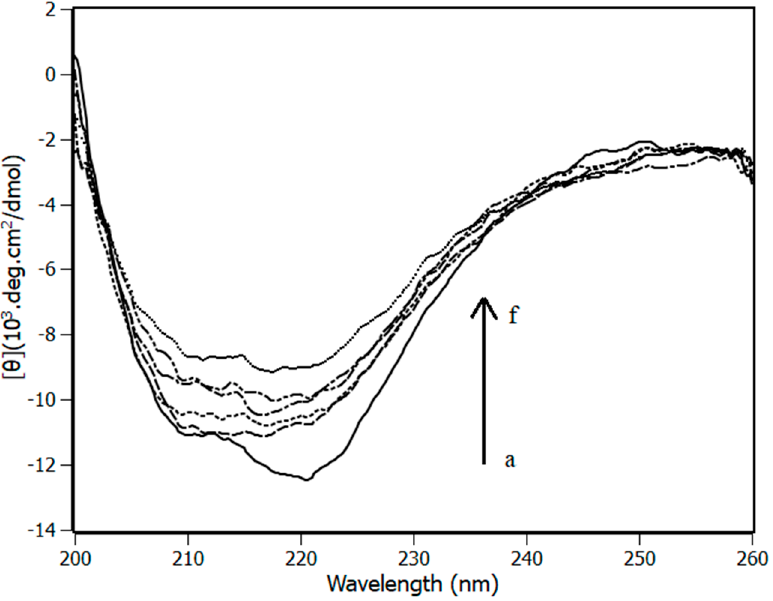
Figure 7. NBD circular dichroism experiments at 298 K in the presence and absence of piperine. Aliquots of piperine were added to the solution from a → f = 1:0 → 1:12.5.